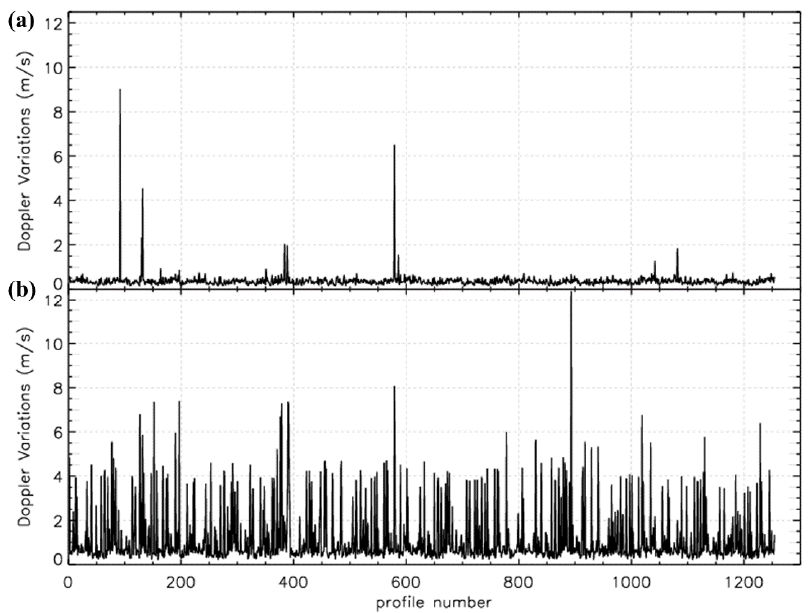
Figure 11. Variation of (a) L1 and (b) L2 Doppler for COSMIC-2 data on July 19, 2019.